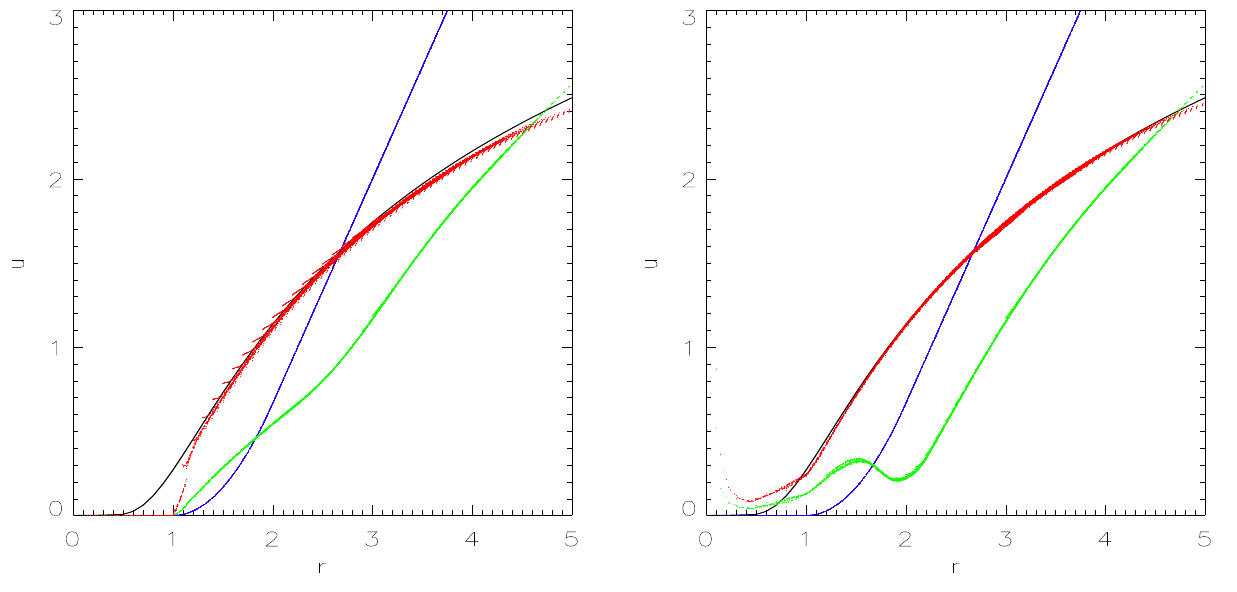
Fig. 5. Comparison of two possible methods to impose a boundary condition for u at the inner boundary r = 1: Dirichlet boundary condition (left) enforcing u | r = 1 = 0 versus inward extrapolation (right). Both diagrams show scatter plots of absolute velocity k u k versus heliocentric radius for all 40 3 grid points as the system converges towards the isothermal Parker wind solution (black solid curve). Colors are used to denote the moment of initialization ( t = 0, blue), an intermediate step ( t = 1, green), and the situation after the stationary equilibrium has been reached ( t = 8, red). Since all grid points are shown, the scatter at a given radius can be seen as a measure of the simulation’s spurious departure from radial